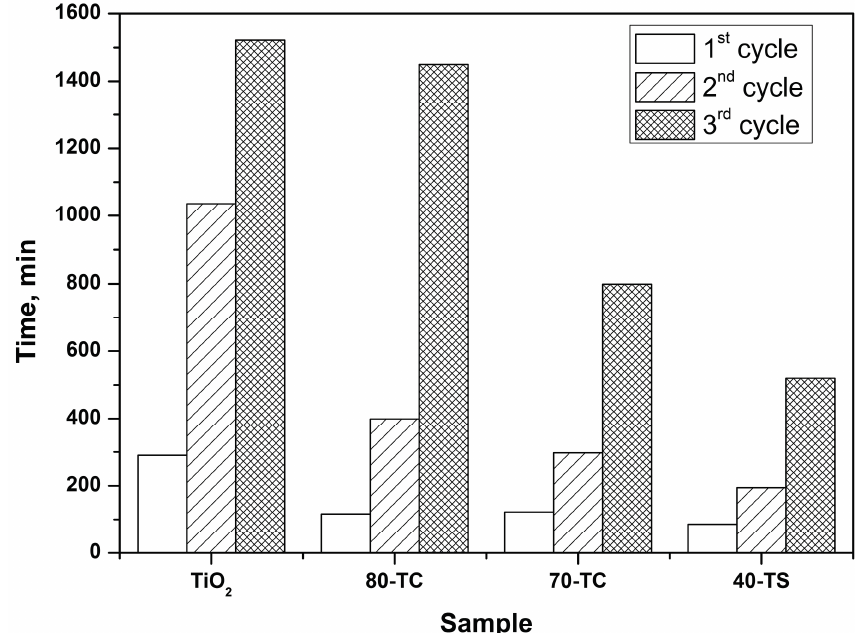
Figure 8. Time values of 90% DES conversion into CO 2 in three oxidation cycles for pure TiO 2 and TiO 2 /adsorbent composite